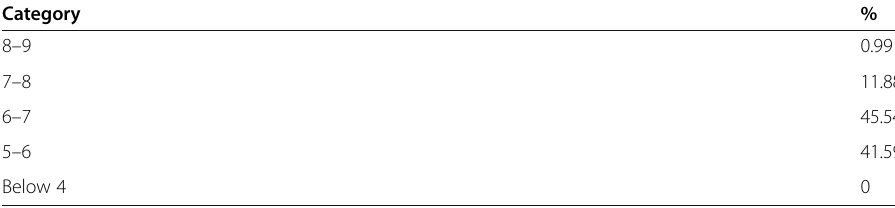
Table 6 The highest IELTS score students achieved